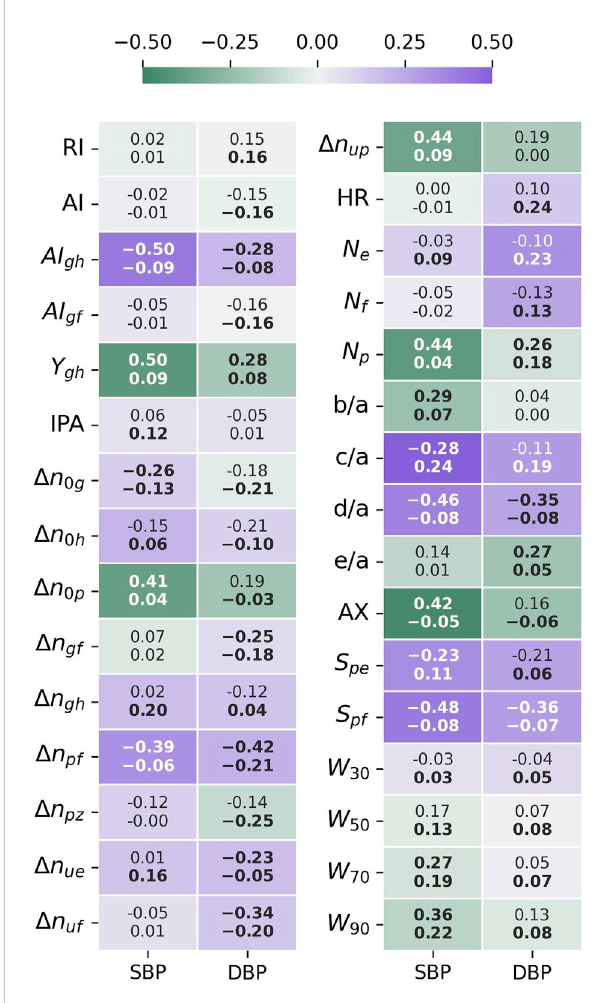
FIGURE 7 Feature-BP Spearman correlation test results. The top value is the correlation coef fi cient for PPG-BP, the bottom value the correlation coef fi cient for UCI, while the color and intensity show by how much UCI differs from PPG-BP. Values in bold indicate that the correlation is signi fi cant ( p <